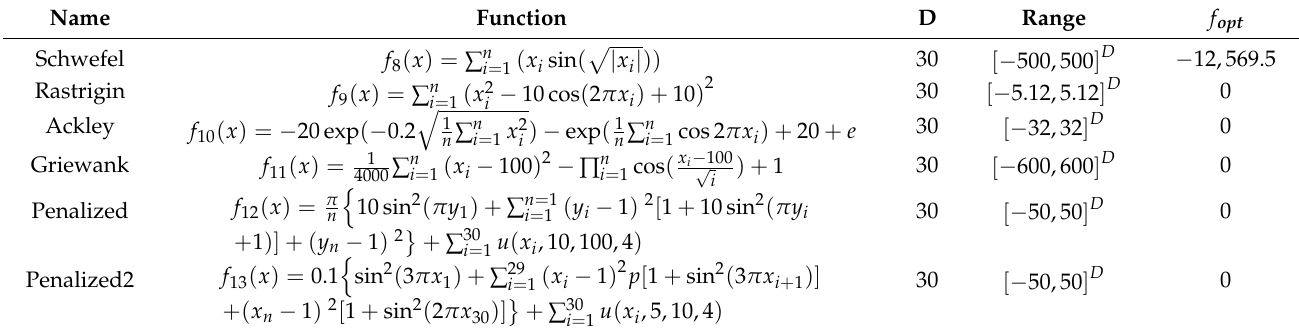
Table A2. Multimodal test functions.